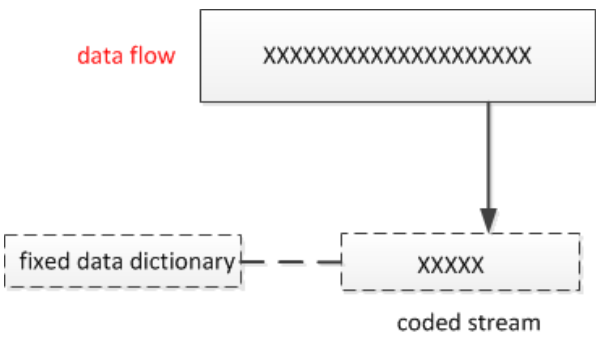
Figure 5 LZ77 algorithm of fixed dictionary tables compress